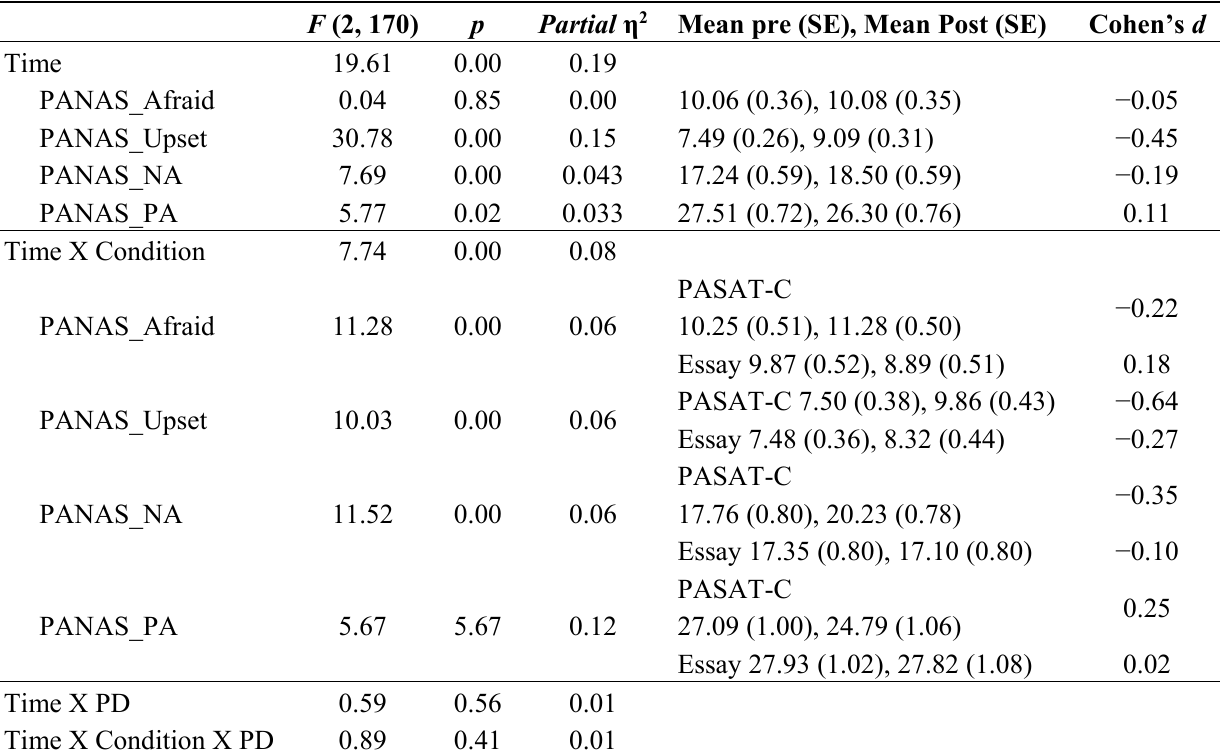
Table 2. Repeated measures MANOVA and follow-up ANOVAs examining the relationship between time, mood induction condition, personality disorder status, and negative affect (upset, afraid, and combined upset and afraid scales). F (2,